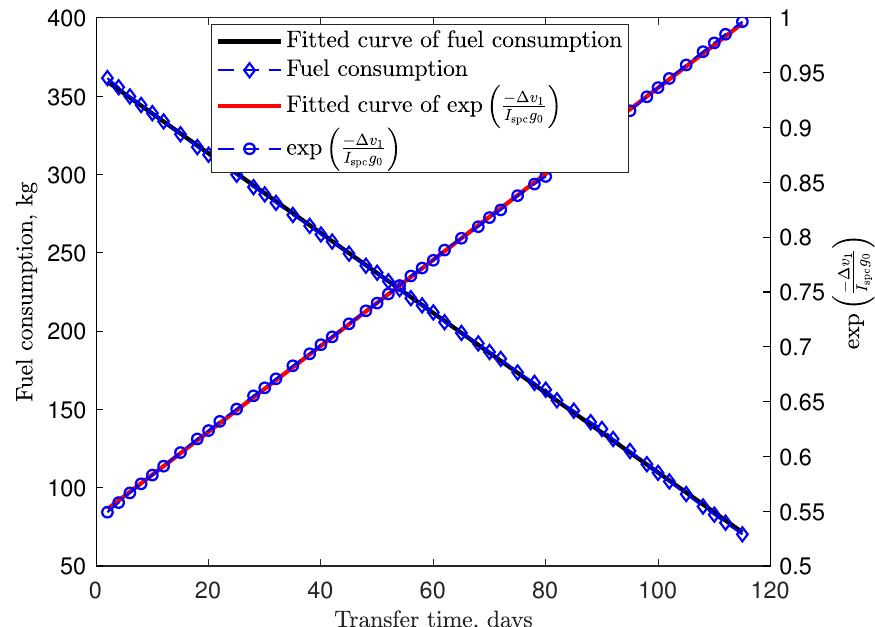
Figure 2. Curve-fitting results of fuel consumption and impulsive burn’s magnitude.